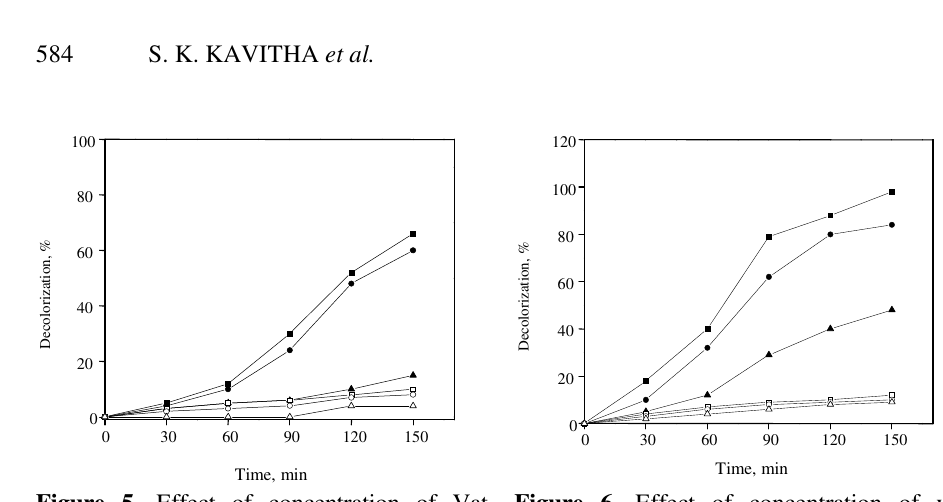
Figure 5. Effect of concentration of Vat Figure 6 . Effect of concentration of vat yellow 4 on the efficiency of decolourization yellow 4 on the efficiency of decolourization in UV light.( ■ ) TiO /UV 5 mg/L, ( ● )TiO /UV in Sun light.( ■ ) TiO /SL 5 mg/L, ( ● )TiO /SL 2 2 2 2 10 mg/L, ( ▲ )TiO /UV 50 mg/L, ( □ ) UV 10 mg/L, ( ▲ )TiO /SL 50 mg/L,( □ ) SL 2 2 5 mg/L, ( ○ ) UV 10 mg/L, ( ∆ ) UV 50 mg/L 5 mg/L, ( ○ ) SL 10 mg/L, ( ∆ ) UV 50